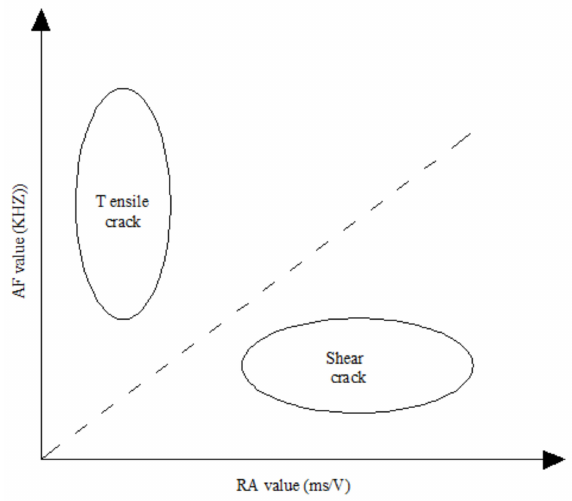
Figure 5. Crack classification using RA and AF